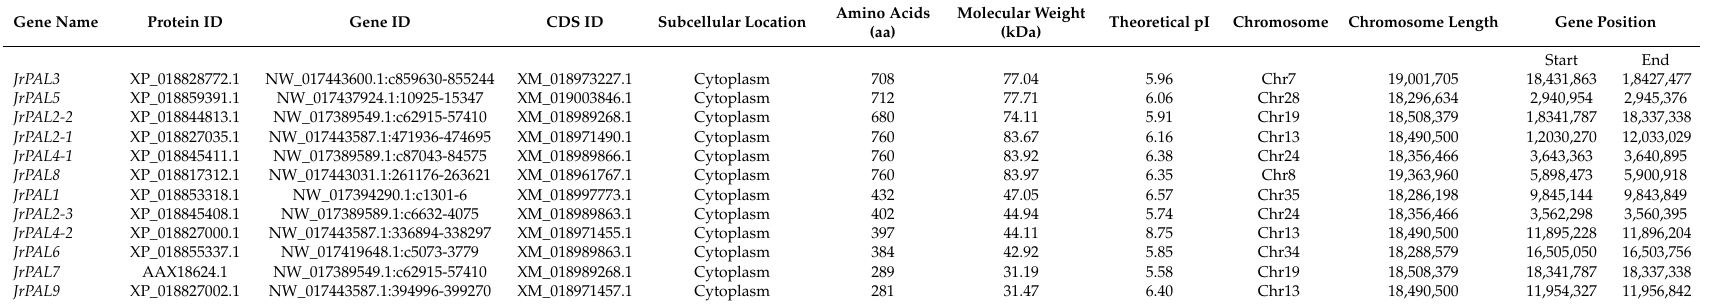
Table 1. Phenylalanine ammnia-lyase (PAL) gene family information in common walnut ( J. regia